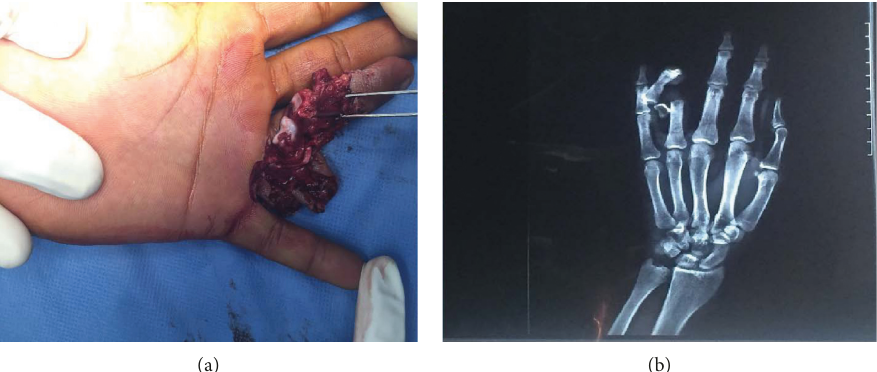
Figure 1: (a) Clinical aspect of the crush injury of the fourth finger. (b) X-rays showed a fracture dislocation of the proximal interphalangeal joint with third